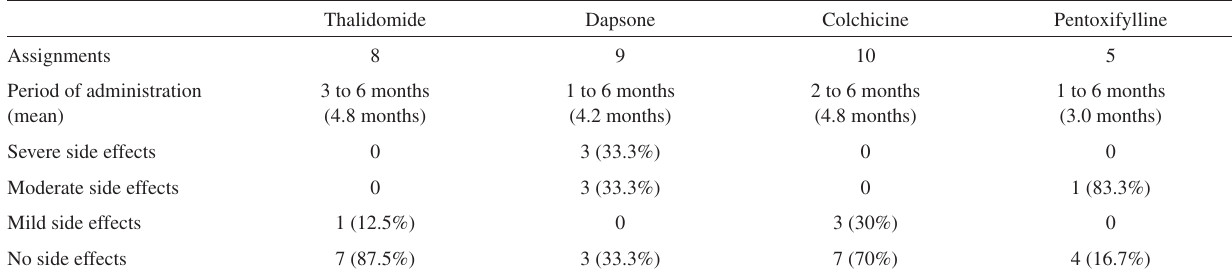
Table 5 - Side effects associated with the